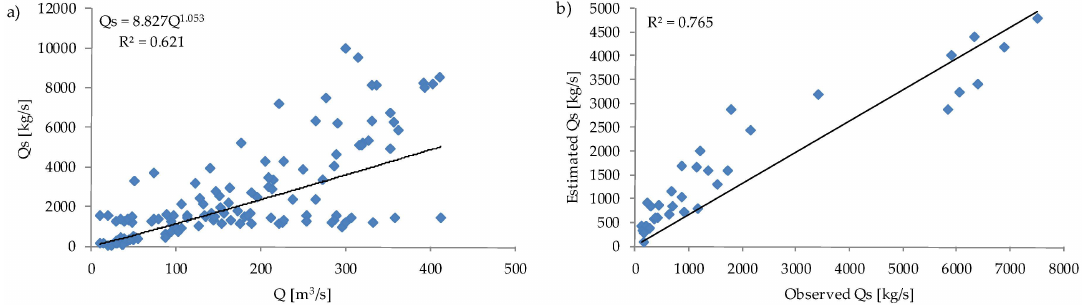
Figure 7. Scatter plot of ( a ) relationship between water and sediment discharge, ( b ) observed and estimated sediment discharge.